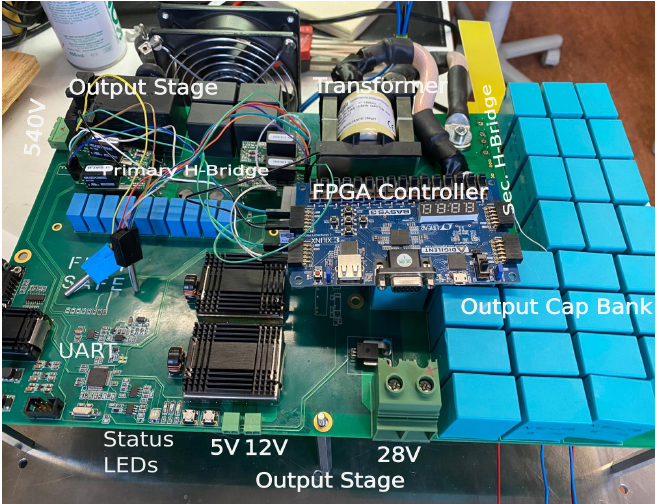
Figure 14. Developed 2.0 kW LLC converter prototype with 28 V/120 A main output and 5 V and 12 V extra